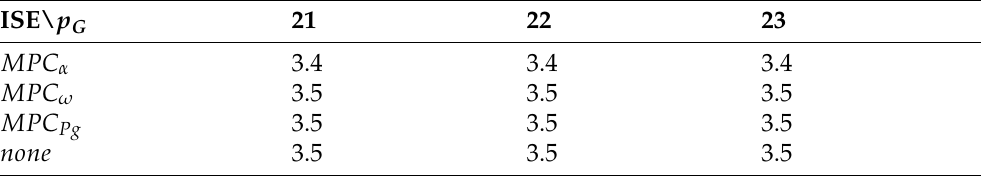
Table 3. MPC tuning for different auxiliary signal (ISE) ( × 10 − 3